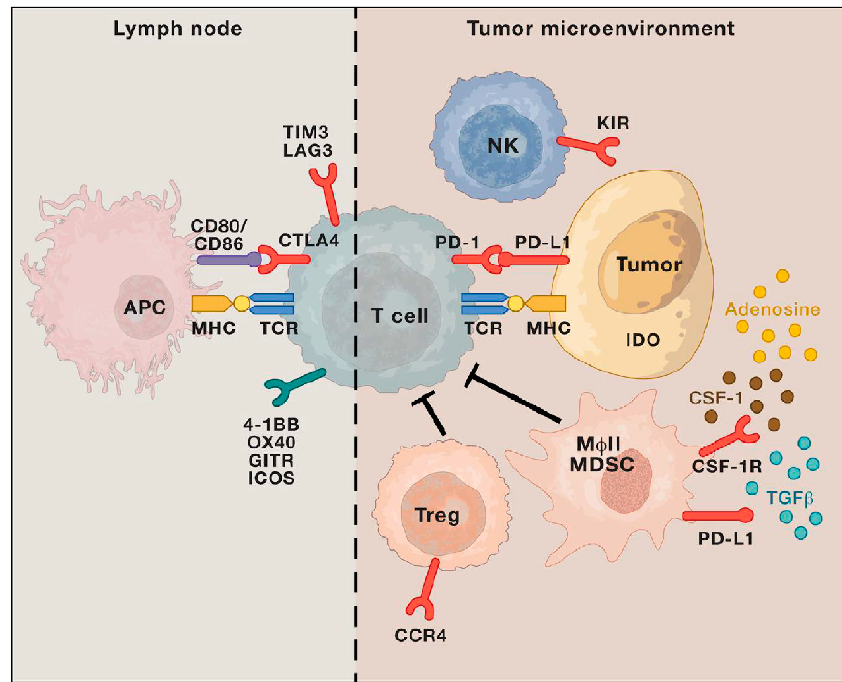
Figure 7. Extrinsic mechanisms of resistance to immunotherapy. Description : Examples of extrinsic mechanisms of resistance, including upregulated or constitutive immune checkpoint expression, immunosuppressive cytokine release (CSF-1, TGF β , adenosine) within the tumor microenvironment, T cell exhaustion and phenotypic alteration, and increased immunosuppressive cell populations (Treg, MDSC, M φ II) [97].